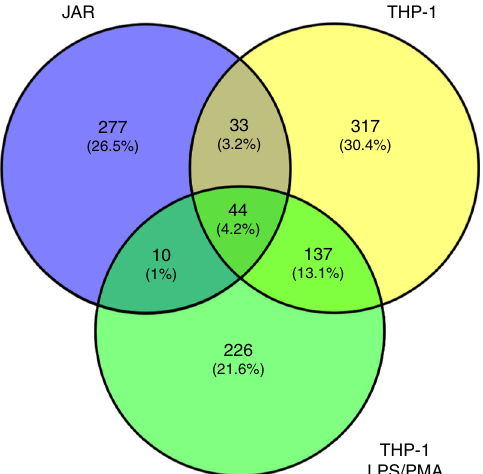
Fig. 1 Limited overlapping of WDD-interacting proteins identi fi ed in the different cellular systems. Venn diagram showing the degree of overlapping between the collection of candidates found in the three cellular systems analyzed (see Supplementary Data 3 for more complete information)